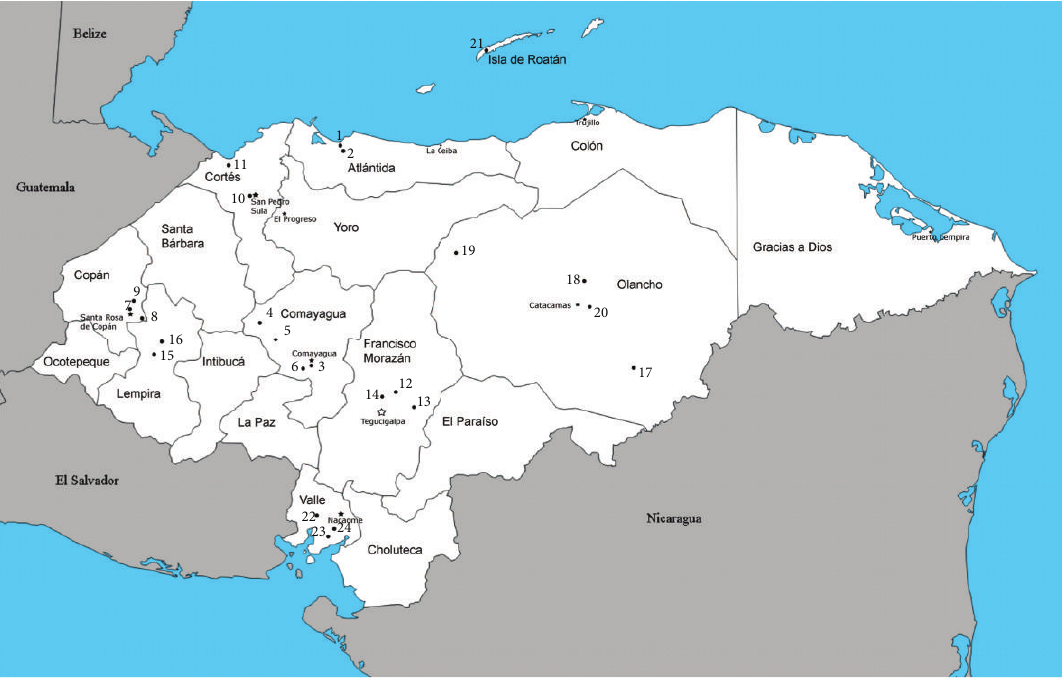
Figure 1: Map of Honduran bat fly collection localities. Locality numbers (numbered closed circles) correspond to specific localities in Gazetteer (Table